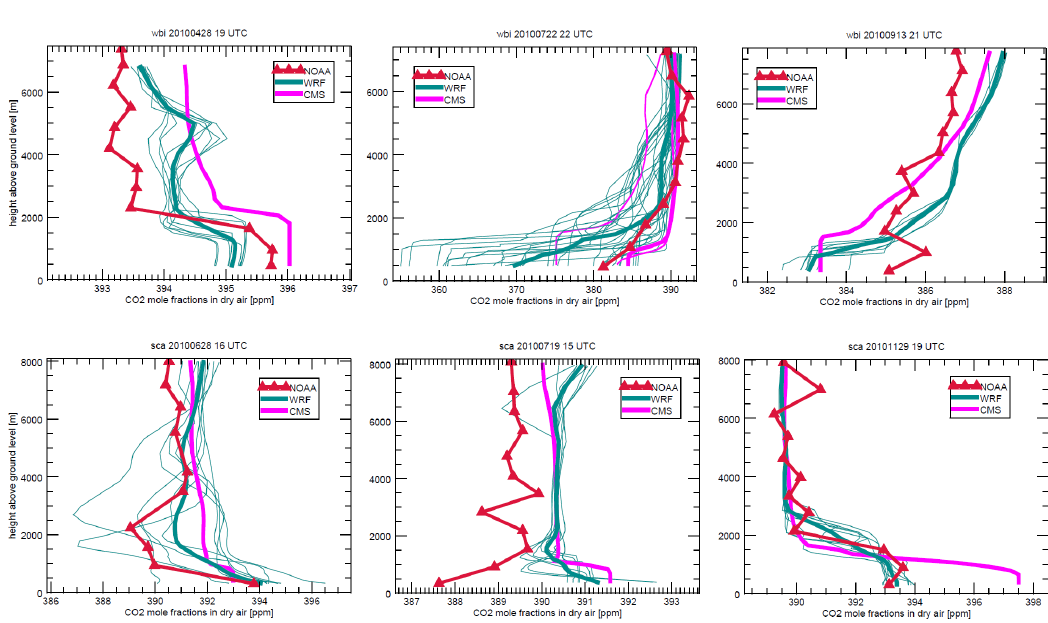
Figure 10. Comparison of CO 2 mole fractions (in ppm) from discrete flask samples collected at two NOAA aircraft profile sites (in red), WBI (West Branch, Iowa), and SCA (Charleston, North Carolina) to modeled CO 2 mole fractions from CMS-Flux (purple triangles) and WRF ensemble realizations (green lines). The reference simulation of WRF (no perturbation of meteorological fields) is indicated by a thick green